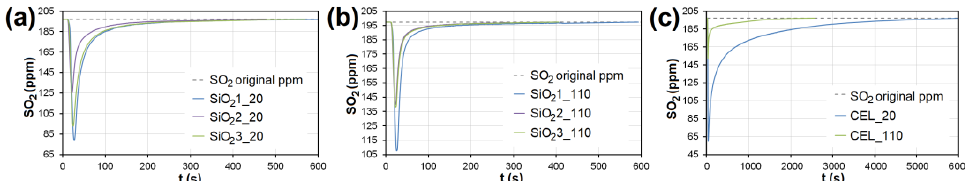
Figure 11. The adsorption curves showing SO 2 adsorption on SiO 2 at adsorbent temperatures of ( a ) 20°C and ( b ) 110 °C. ( c ) The adsorbing curve showing SO 2 adsorption on CEL at adsorbent temper- atures of 20°C and 110 °C. SiO 2 1-3 — silicon dioxide at different granulometric fractions (see Table 1), CEL — cellulose.